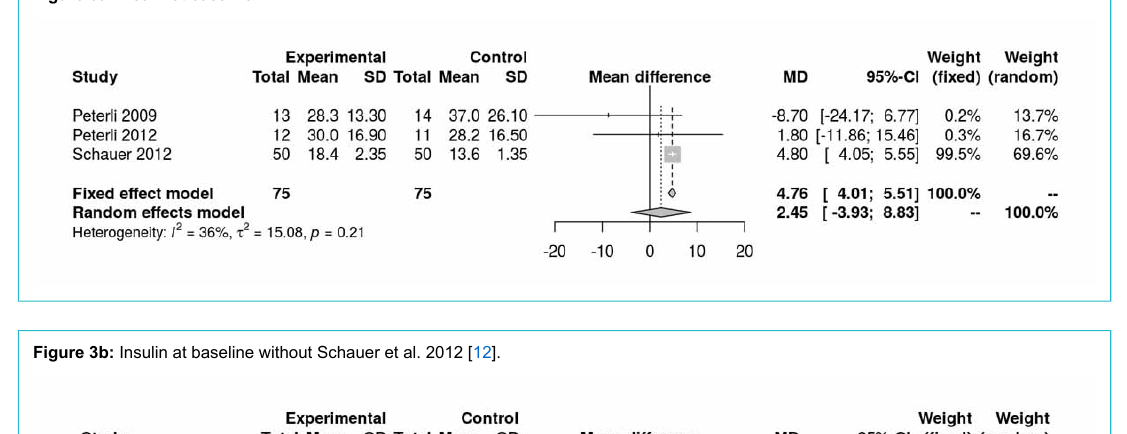
Figure 3b: Insulin at baseline without Schauer et al. 2012 [12].